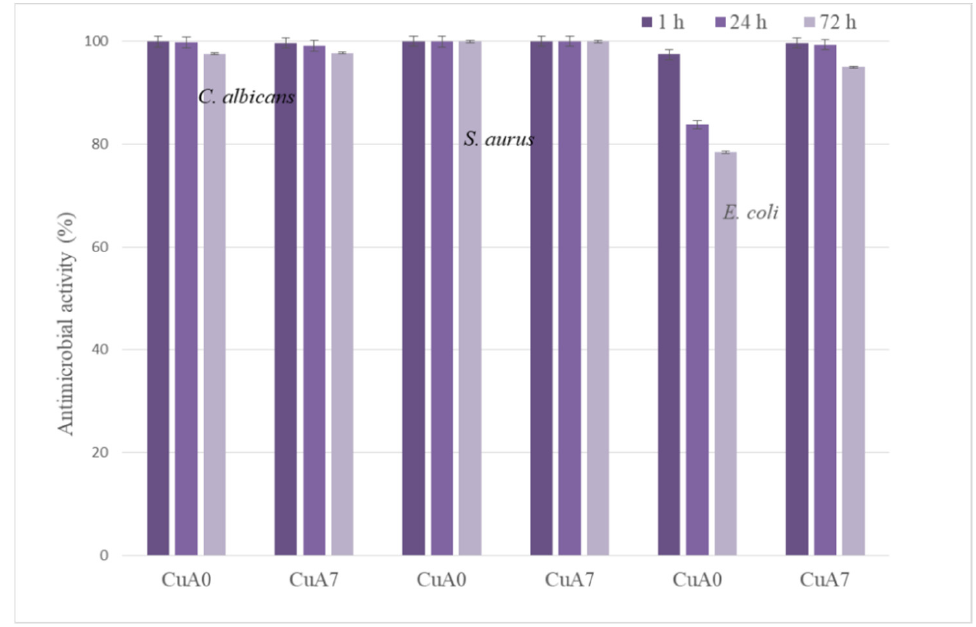
Figure 4. Antimicrobial activity of copper(II) ions in poly(acrylate/itaconic acid) matrices in contact with C. albicans , S. aureus , and E. coli .